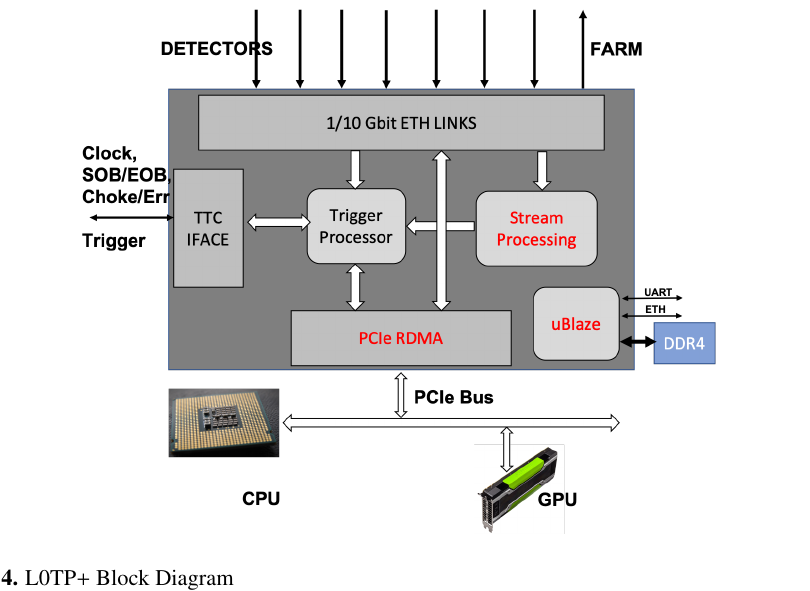
Figure 4. L0TP + Block